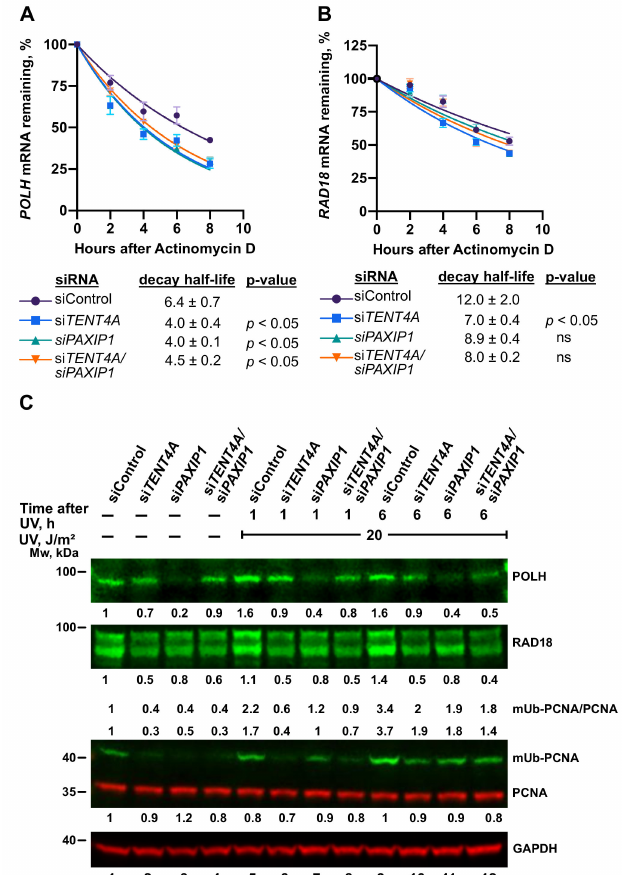
Figure 8. Effect of TENT4A and PAXIP1 on the stability of TLS-related mRNAs and level of TLS- related proteins. ( A , B ) TENT4A and/or PAXIP1 expression was knocked down in MCF-7 cells for 48 h, after which the cells were treated with 5 µ g/mL Actinomycin D for up to 8 h. The expression levels of POLH and RAD18 were each determined by qPCR relative to the expression level at time 0. Half-life was calculated using a non-linear fit one-phase decay curve equation. The significance of the differences was calculated using Student’s t -test (one-tailed); Data are presented as mean ± SEM from three independent experiments. ns, non-significant; p > 0.05. ( C ) MCF-7 cells were transfected with TENT4A and/or PAXIP1 or non-targeting control siRNA for a final combined concentration of 100 nM. At 65 h post-transfection, the cells were UV-irradiated at 20 J/m 2 and harvested 1 or 6 h post-irradiation. Whole-cell extracts were fractionated by SDS-PAGE followed by Western blot with indicated antibodies. Amounts are presented relative to those in extracts of unirradiated cells treated with siControl and the values are shown in the corresponding position of the